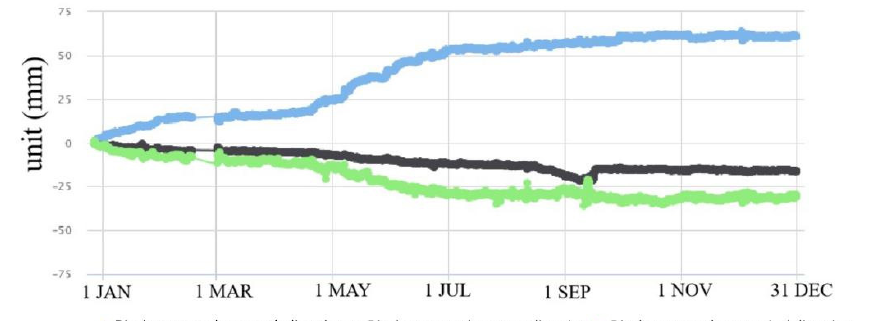
Figure 9. Displacements recorded by GPS 06 in 2016.